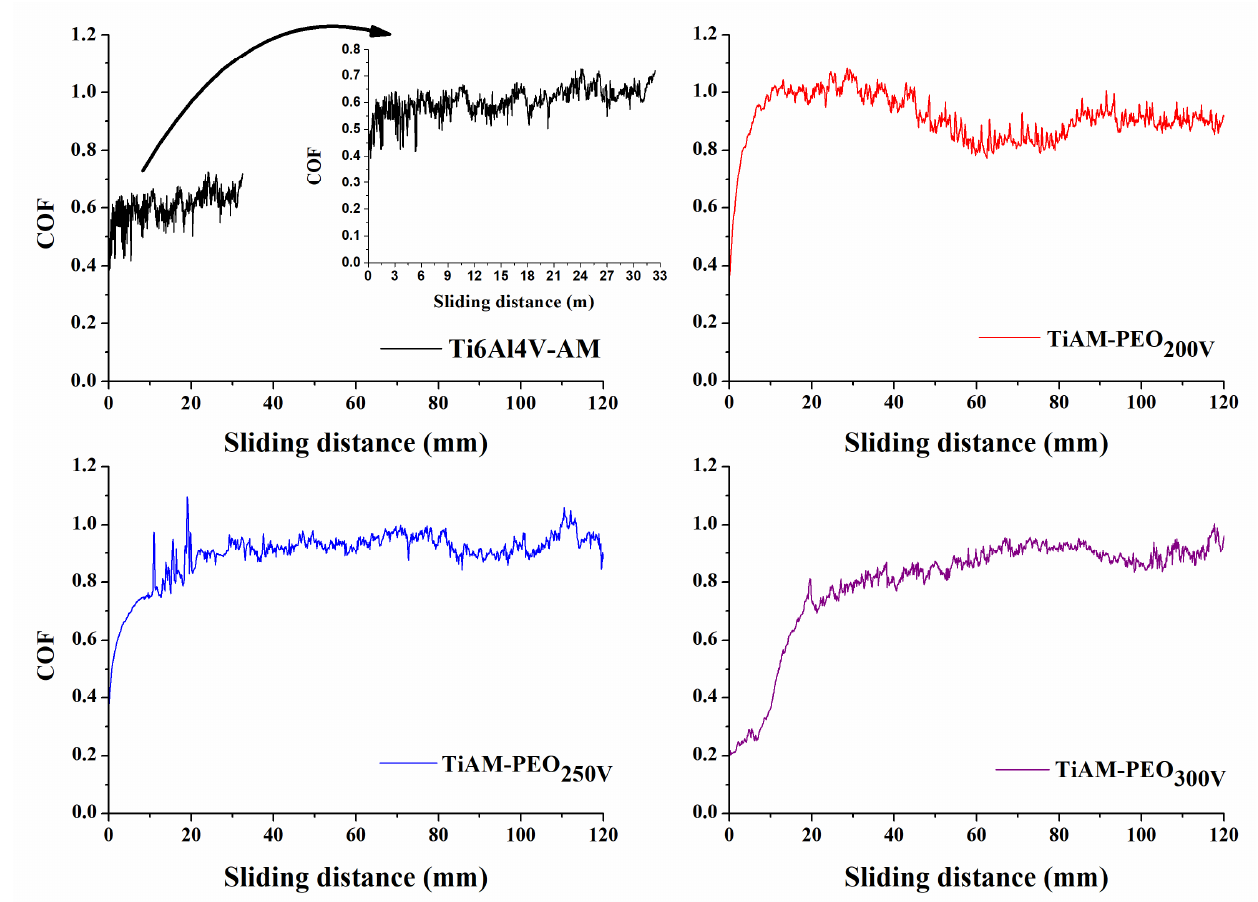
Figure 4. Coefficient of friction (COF) of coatings obtained by PEO on Ti-6Al-4V ELI alloy processed by L-PBF as a function of time (load of 1 N, frequency of 3 Hz, and stroke length of 3.0 mm, against body = zirconia sphere stabilized with yttria).